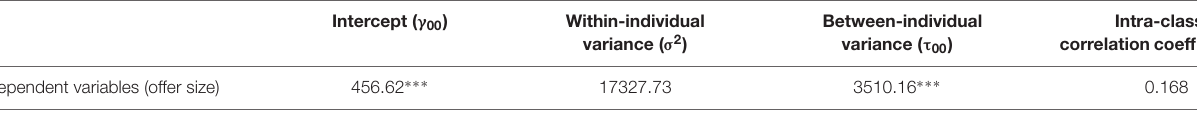
TABLE 2 | Parameter estimates and variance components of null model for monetary offers.